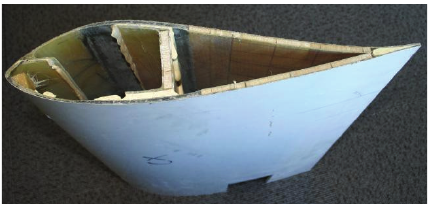
Figure 2: Cross section view of